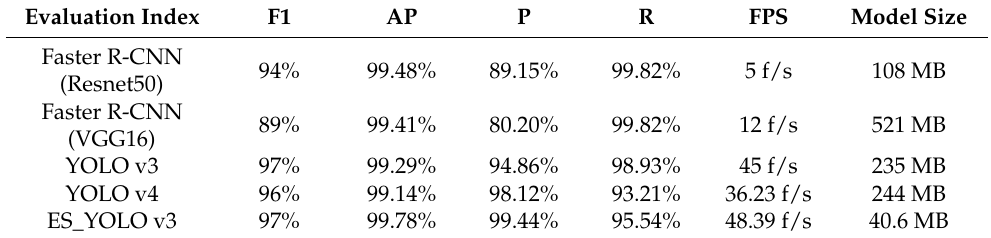
Table 4. Comparison of recognition effect between this model and other